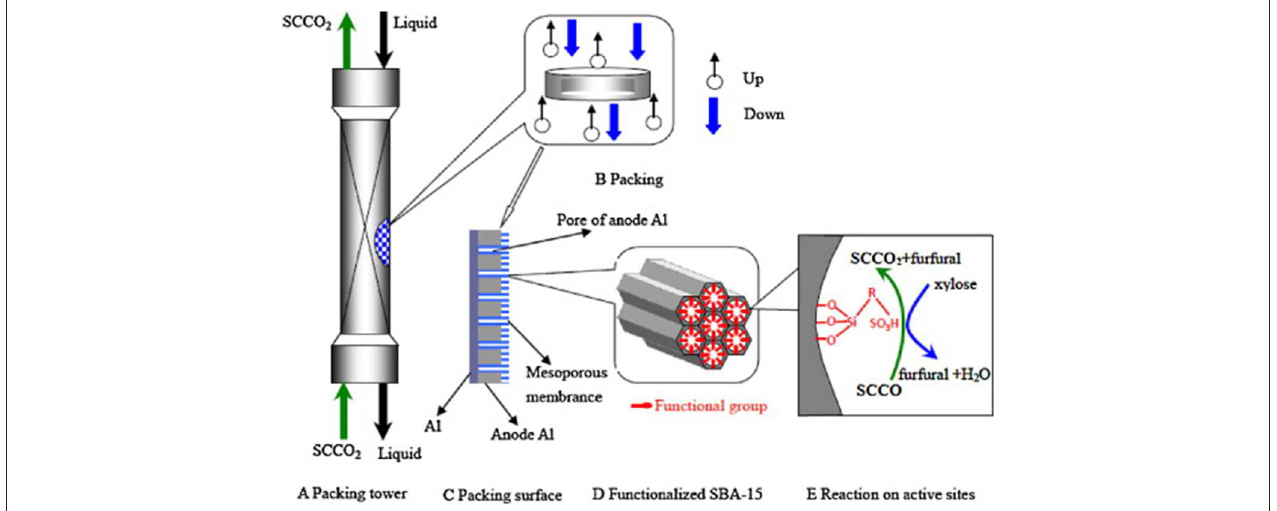
FIGURE 3 | The scheme of solid acid catalyst packing and dehydration of xylose to furfural. Reprinted from Hua et al. (2013), with permission from Elsevier.